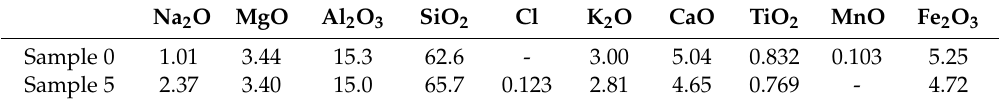
Figure 4. X-ray di ff raction (XRD) di ff raction patterns of di ff erent samples. Figure 4. X-ray diffraction (XRD) diffraction patterns of different samples. Table 2. X-ray fluorescence (XRF) results of Samples 0 and Table 2. X-ray fluorescence (XRF) results of Samples 0 and 5.